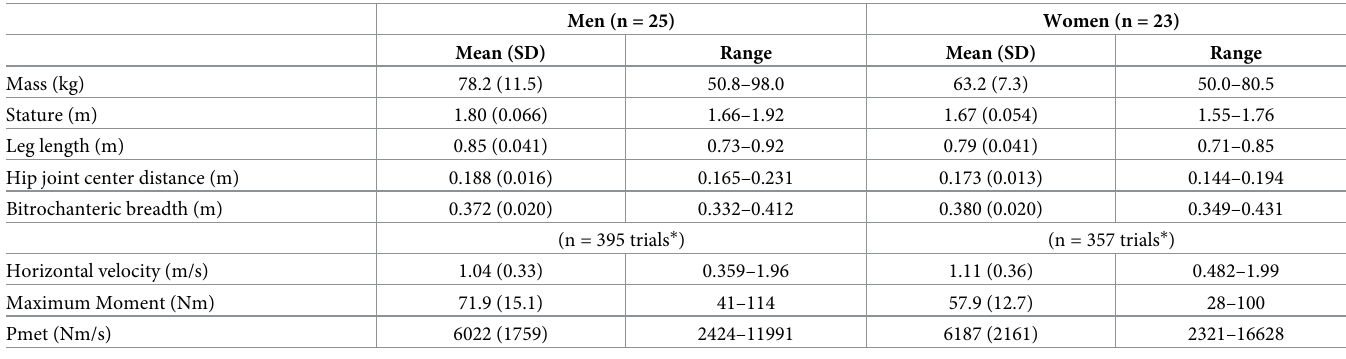
Table 1. Mean and range of sample